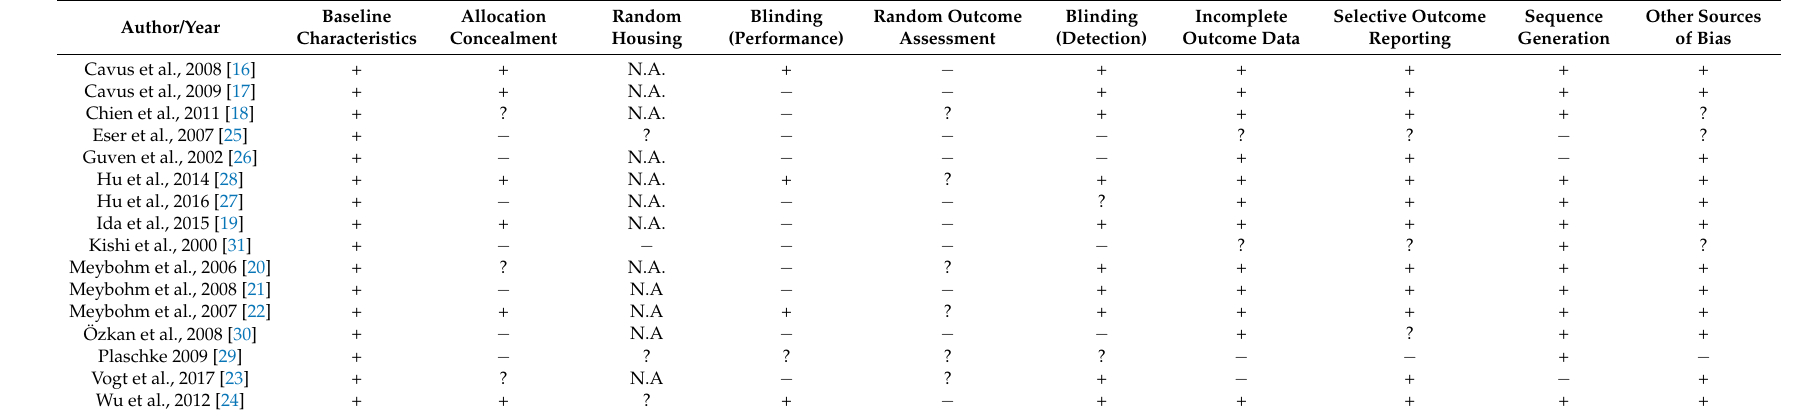
Table 5. SYRCLE’s risk of bias tool.